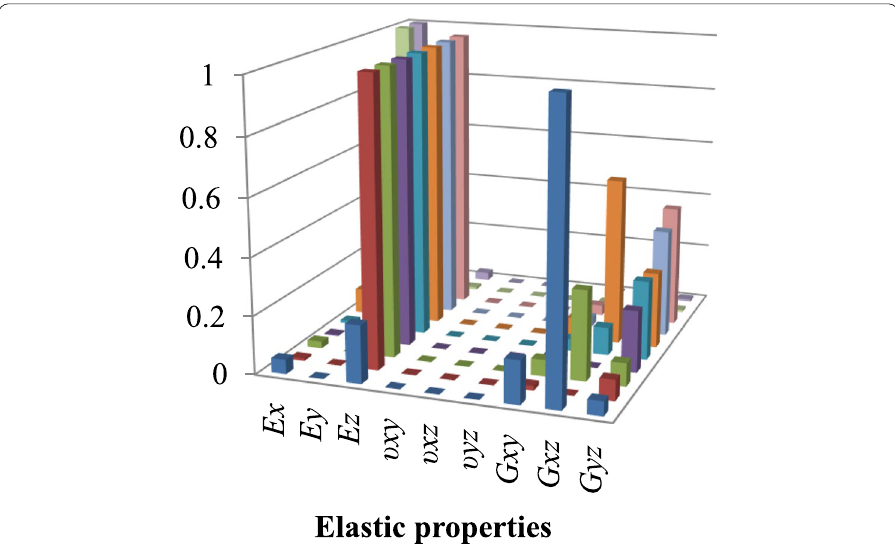
Fig. 14 Sensitivity analysis for